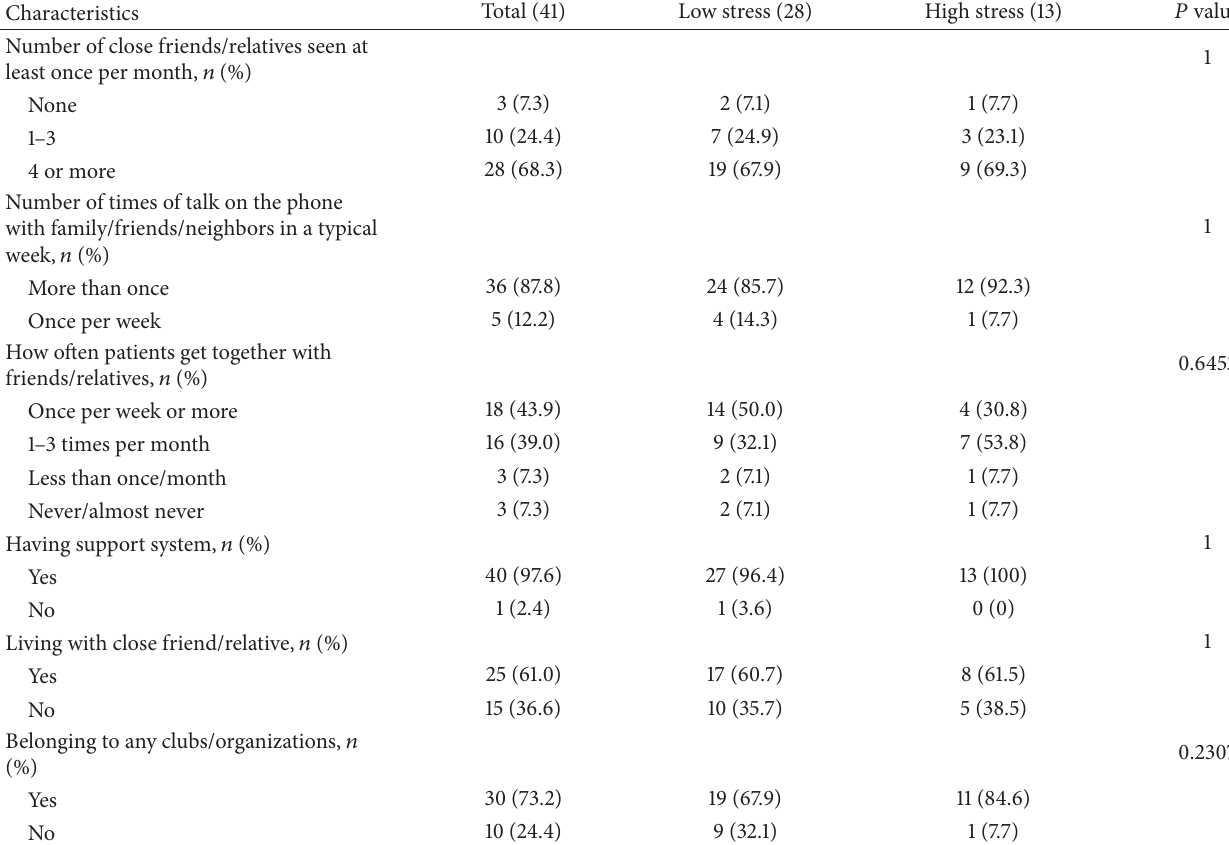
Table 3: Social support characteristics of SLE cases in categories of high and low stress ( 𝑁 = 41 ).